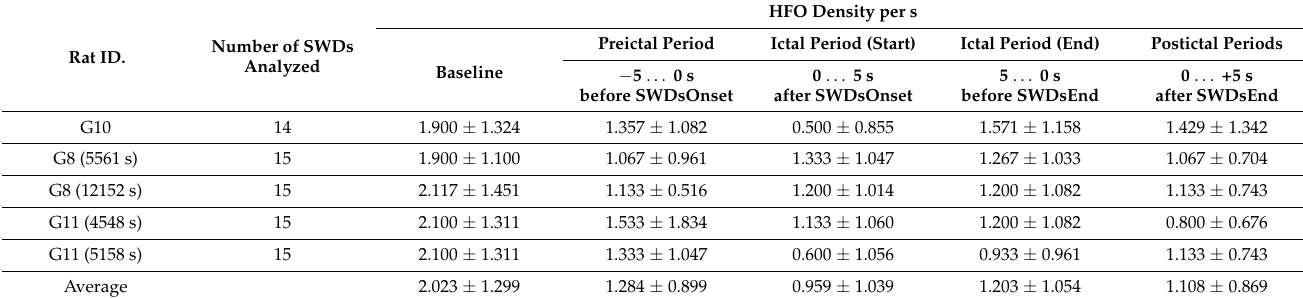
Table A2. Density of HFO per 5 s (mean ± standard